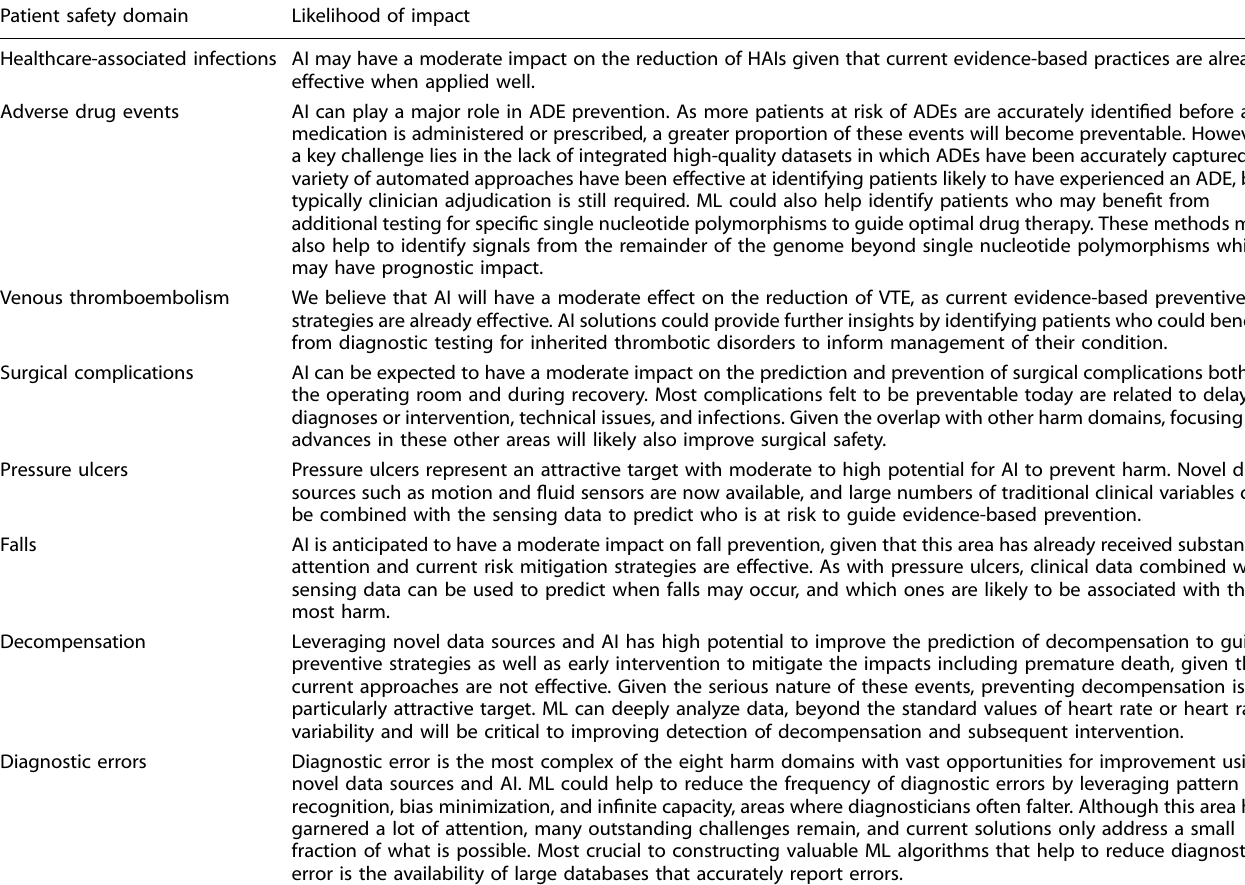
Table 3. Evaluation of the potential of arti fi cial intelligence to improve patient safety in the eight harm domains. Patient safety domain Likelihood of